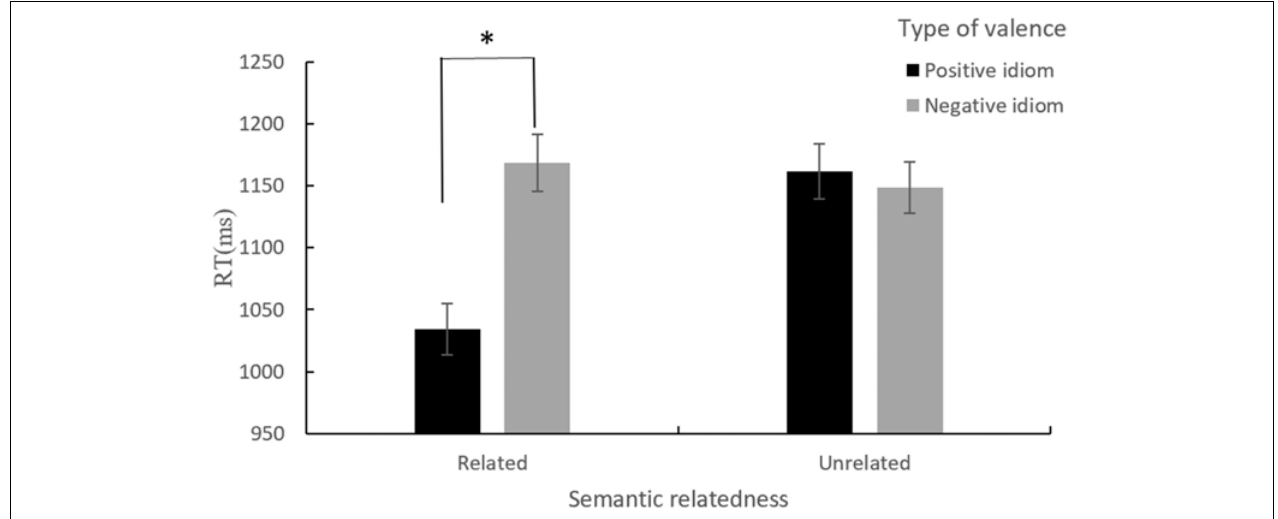
FIGURE 3 | An interaction between semantic relatedness and type of valence for RTs. ∗ p <